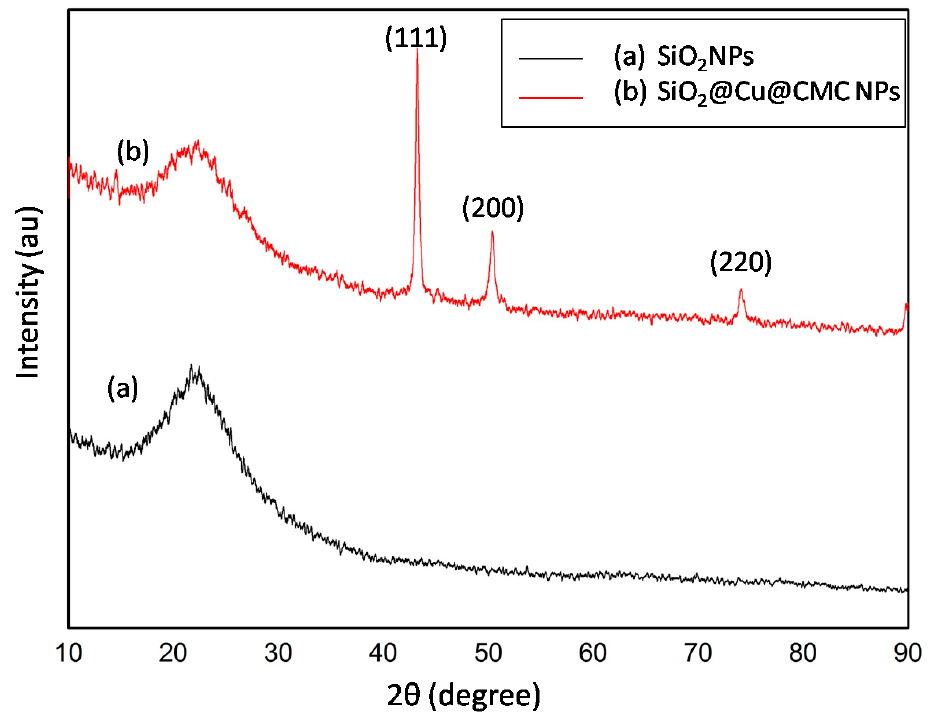
Figure 2. XRD patterns of the powder samples. XRD pattern of SiO 2 NPs ( a ) and XRD pattern of SiO 2 @Cu@CMC NPs ( b ).